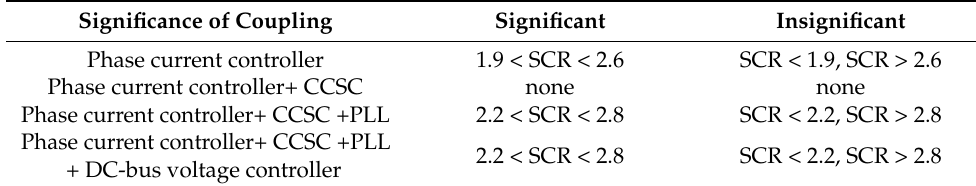
Table 3. Significance evaluation of frequency coupling.